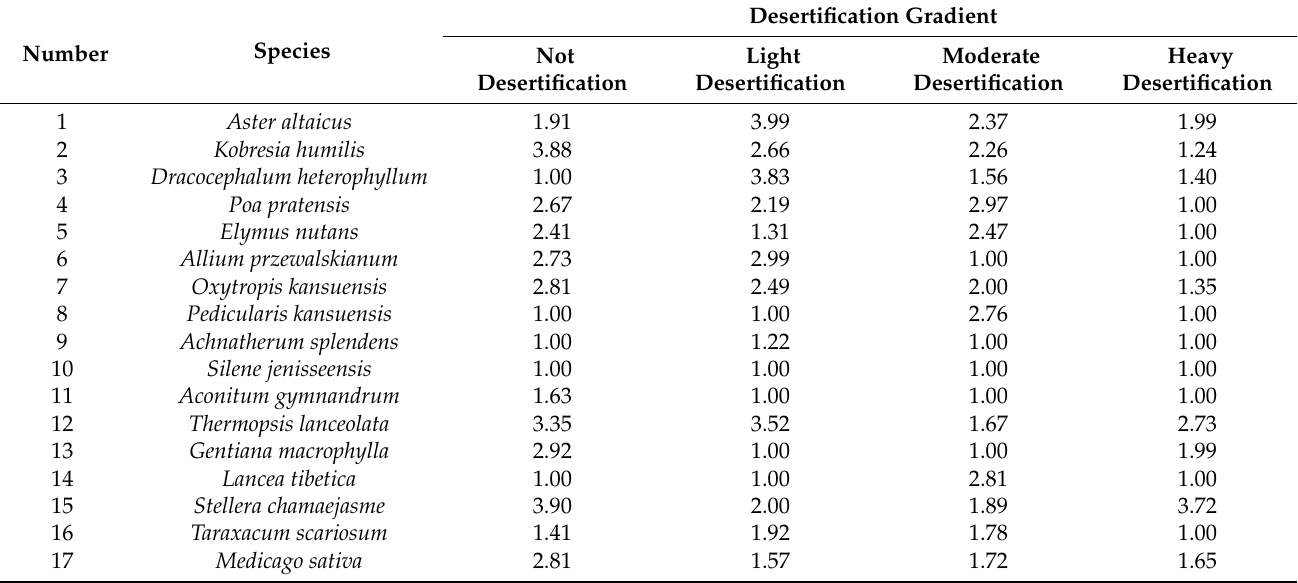
Table 1. Levins niche widths of main plant species in different desertification stages. This table shows the quantified ecological widths of 17 major species in different desertification